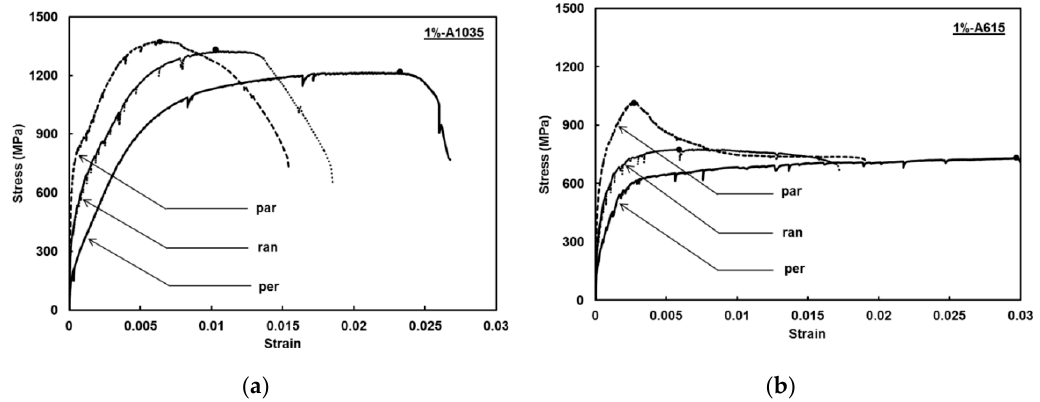
Figure 18. Effect of fiber orientation on the stress versus strain response: ( a ) A1035 bars with 1% fibers; ( b ) A615 bars with 1% fibers.